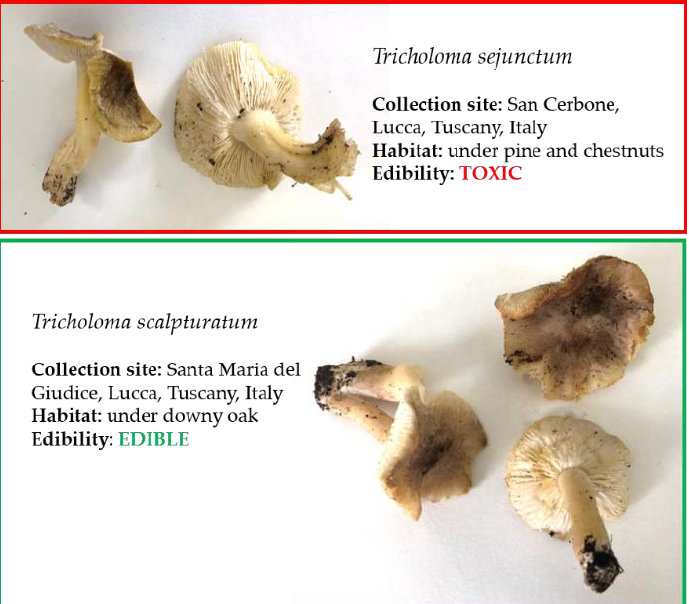
Figure 3. Pictures of collected specimens from Tricholoma spp. with relative collection site and habitat. Morphologic similarity among toxic ( T. sejunctum ) and edible ( T. scalpturatum ) species can be observed. Table 2. Samples collected in this study (species and specimens number) and obtained ITS refer- ence sequences used to set up and validate the ITS gene dataset. * sequences matching uniquely with the corresponding species but with identity values < 97%; ** sequences simultaneously matching with the corresponding species and one other of the same edibility, with identity values ≥ 98%. Species Edibility Specimens (n) ITS Ref. Seq. (n)